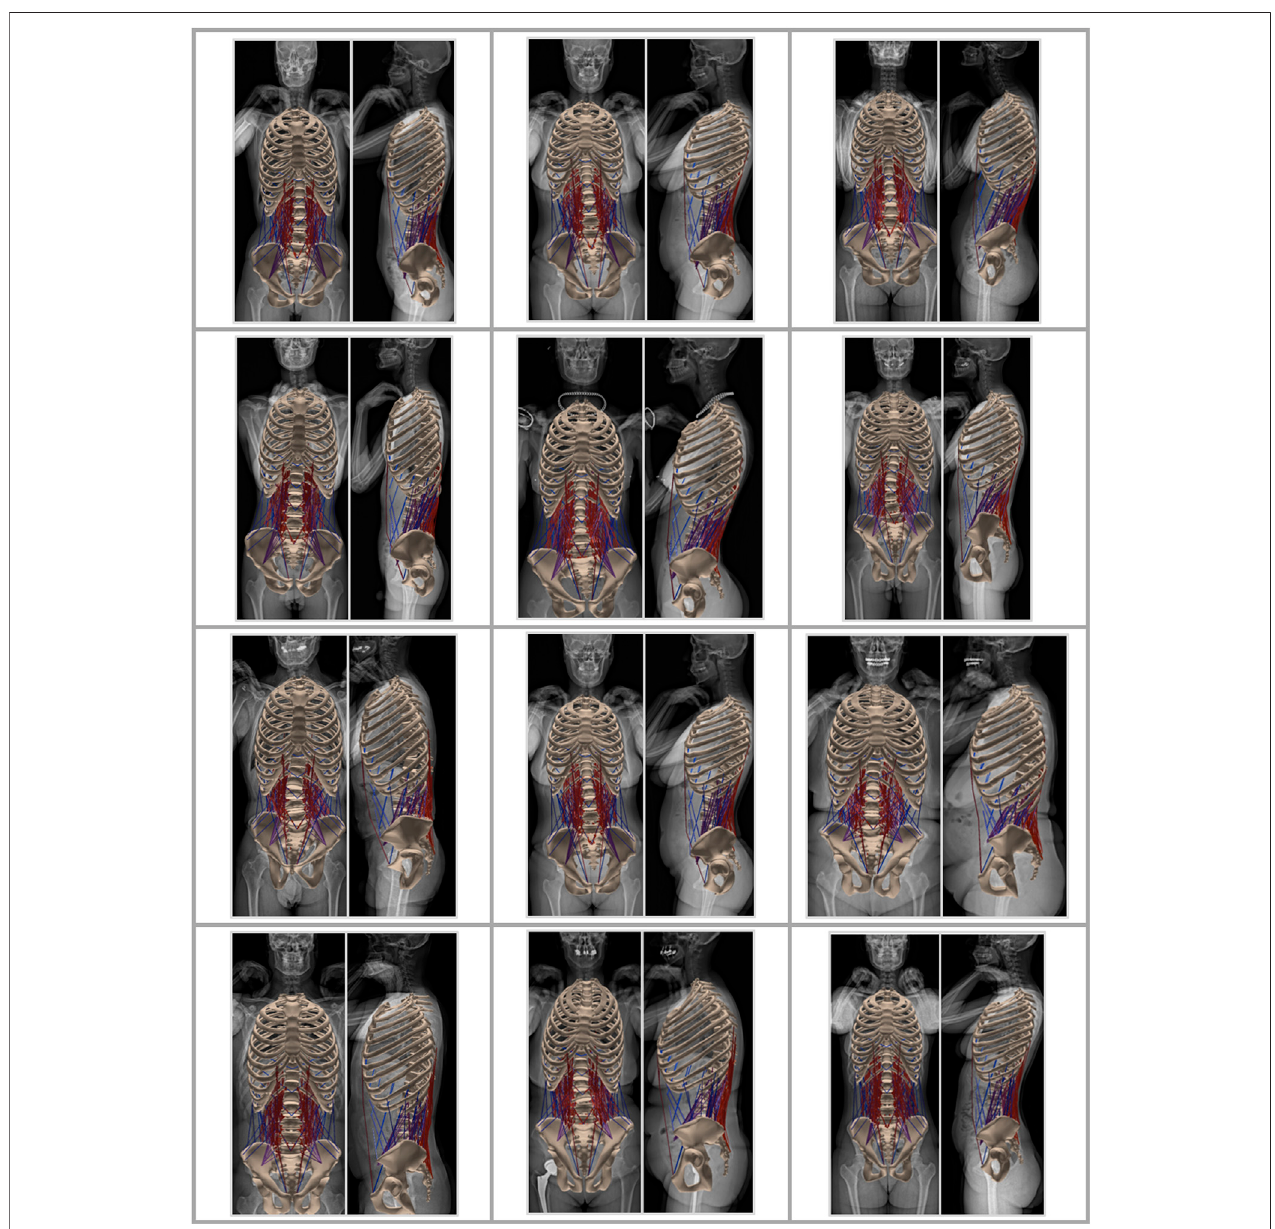
FIGURE 2 | Musculoskeletal models generated based on the EOS images of 12